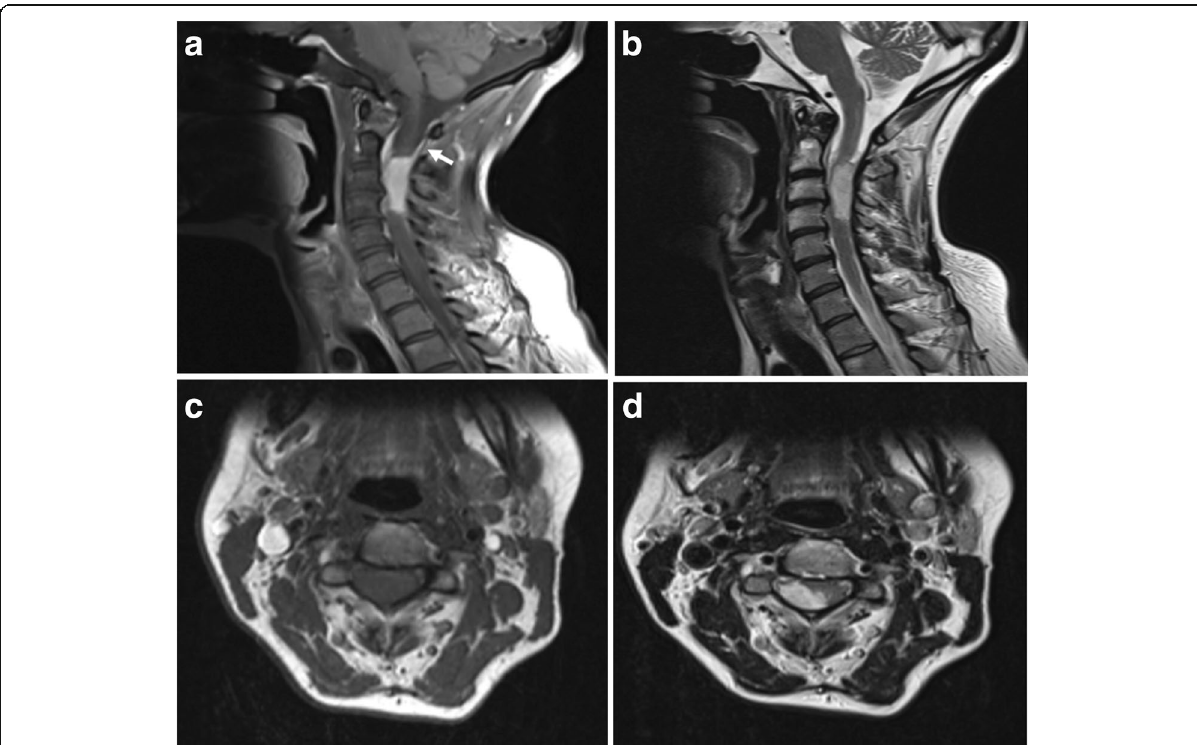
Fig. 6 Dural glioblastoma metastasis. a Post-contrast sagittal T1-weighted MR image showing an avidly enhancing intra-dural, extra-medullary lesion within the upper posterior cervical spine. An enhancing dural tail is seen superiorly (white arrow). b T2-weighted sagittal images of the same lesion. c , d Axial T1 and T2-weighted images show the posterior intra-dural and extra-medullary location of the lesion which is compressing the cord to the